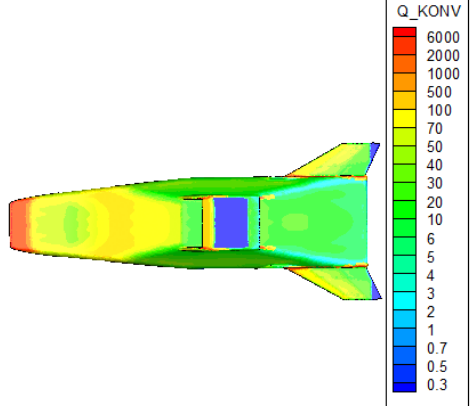
Figure 4. Distribution of convective heat flux q w (kW/m 2 ) for the lower part of the X-43, Mach number M = 6, height H = 25 km, attack angle α = 10 ◦ .